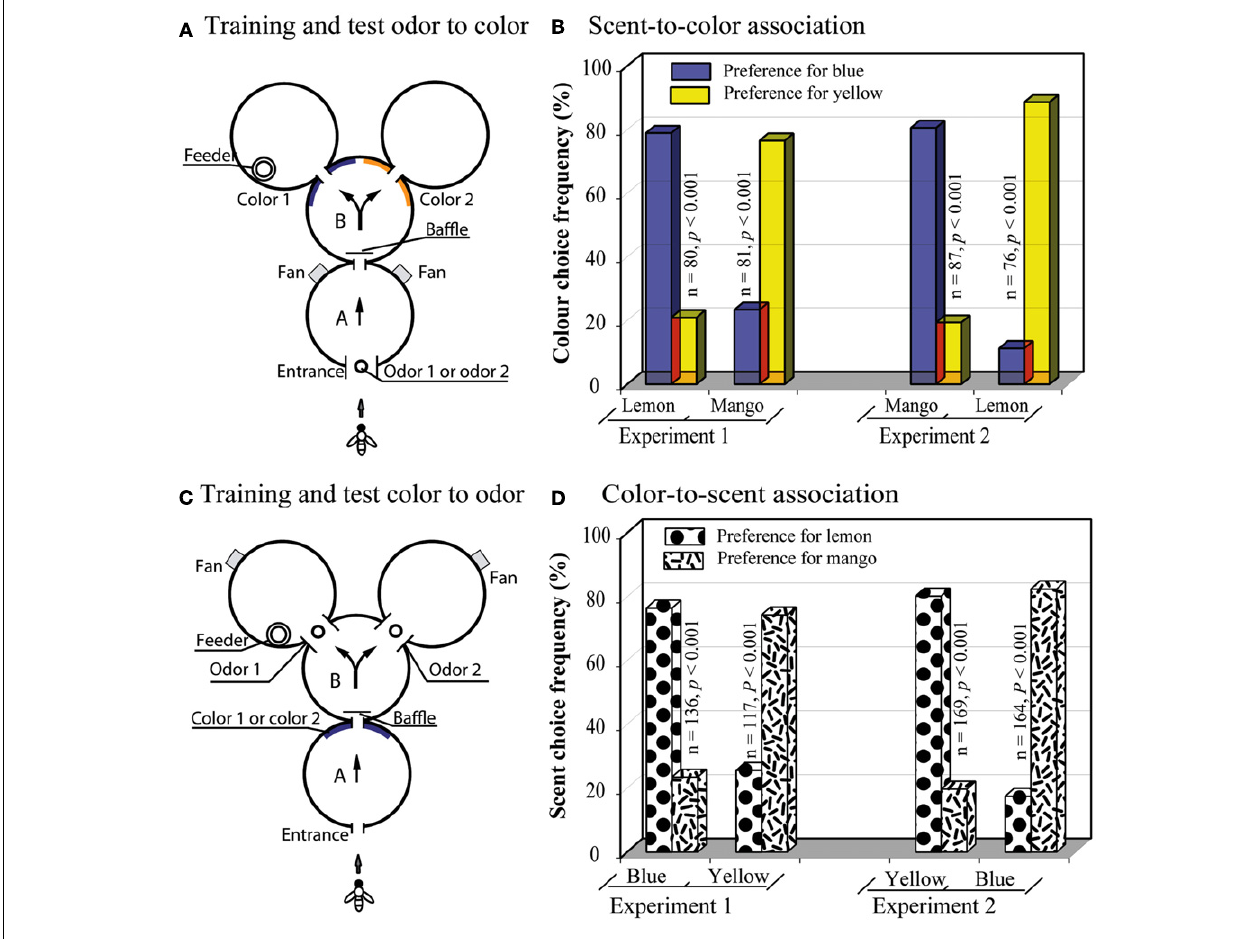
Y -maze setup with color presentation in the first chamber. (D) Results of the scent-to-color association tests. Modified from Srinivasan et al. (1998). Details in